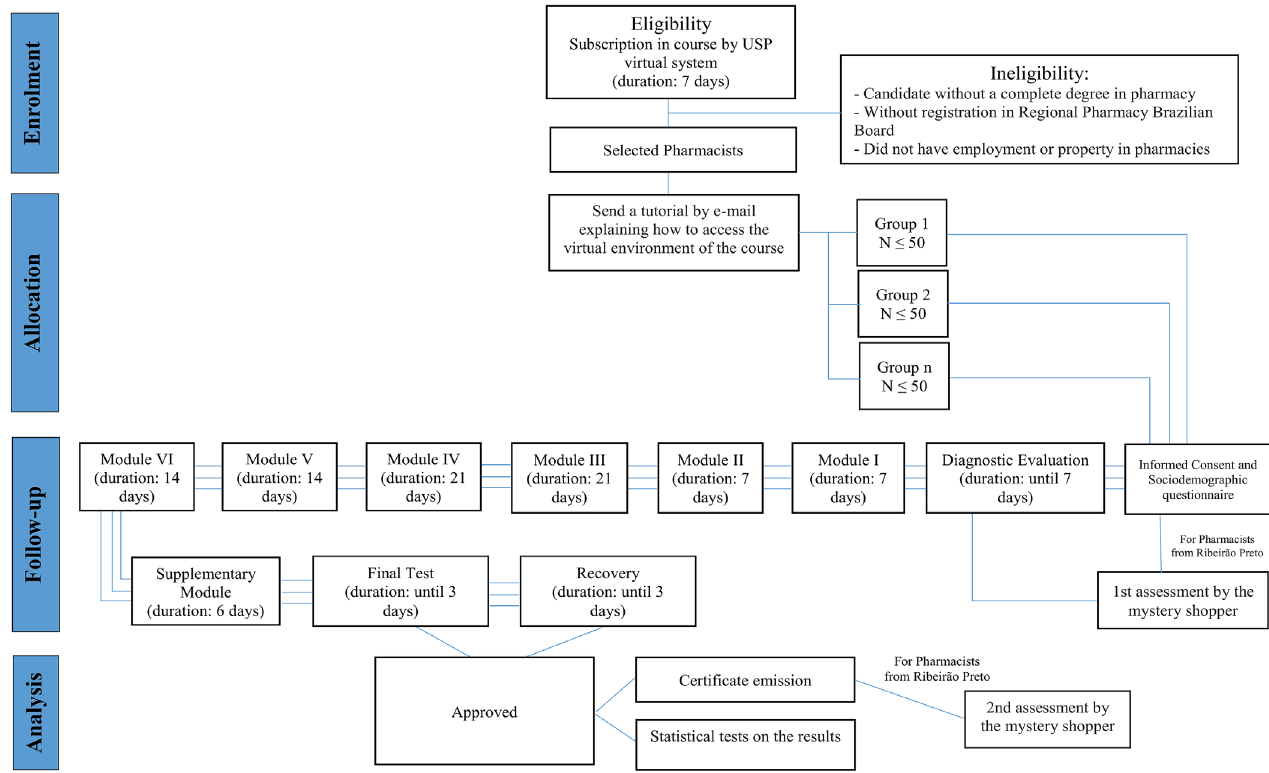
FIGURE 3 - Study design and participant